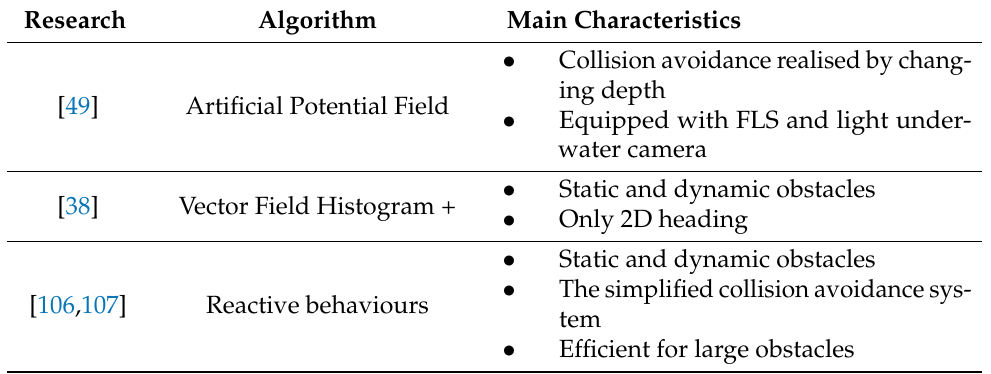
Table 3. List of algorithms in real applications until